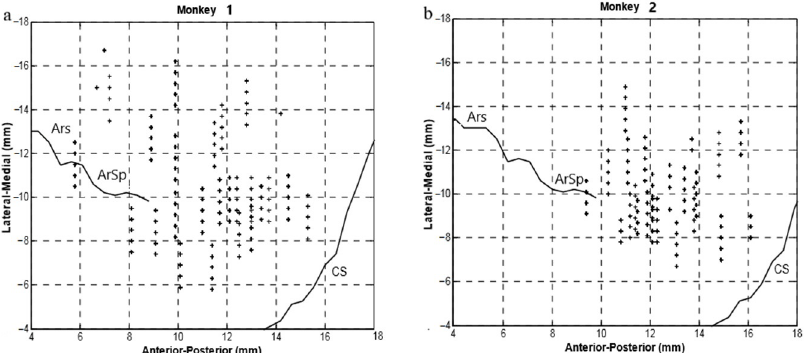
Figure 1. Top view of the electrode penetration locations in the chamber’s coordinates (left hemi- spheres). ( a ) for Monkey 1; ( b ) for Monkey 2. Each cross represents an electrode penetration. ArS: arcuate sulcus; ArSp: arcuate sulci spur; CS: central sulcus (the brain landmarks were added based on stereotaxic coordinates).